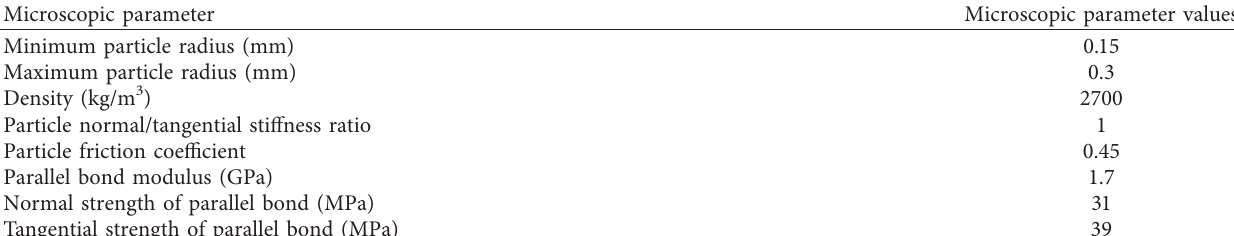
Table 4: Microscopic parameter values.